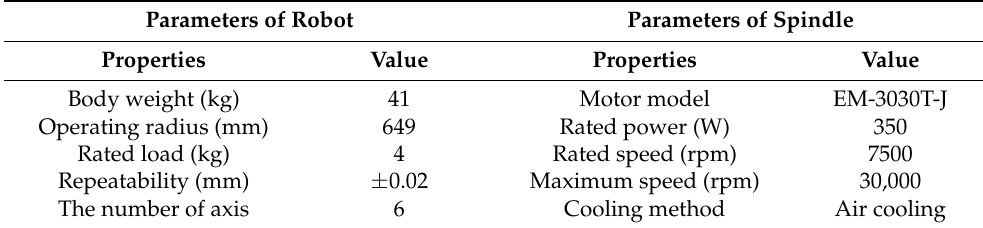
Table 3. Parameters of experimental